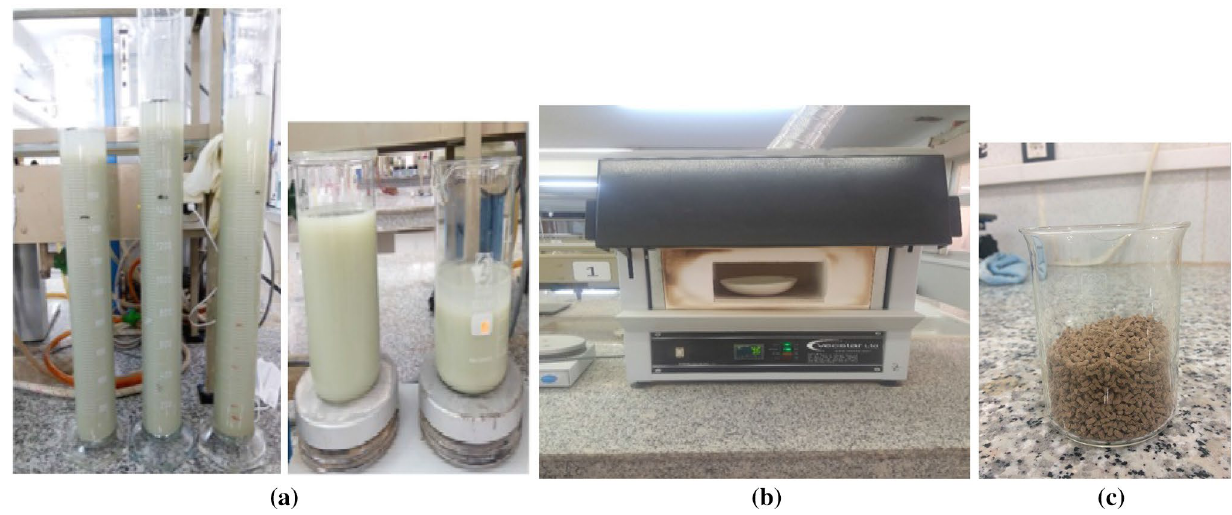
Fig. 1 Preparatory steps of calcined clay in the form of granules ( Source: Original, 2019). a Method of sedimentation and drying of Kenadsa’s natural green clay (Bechar-Algeria); b Calcination of clay in a muffle furnace; c Calcined clay